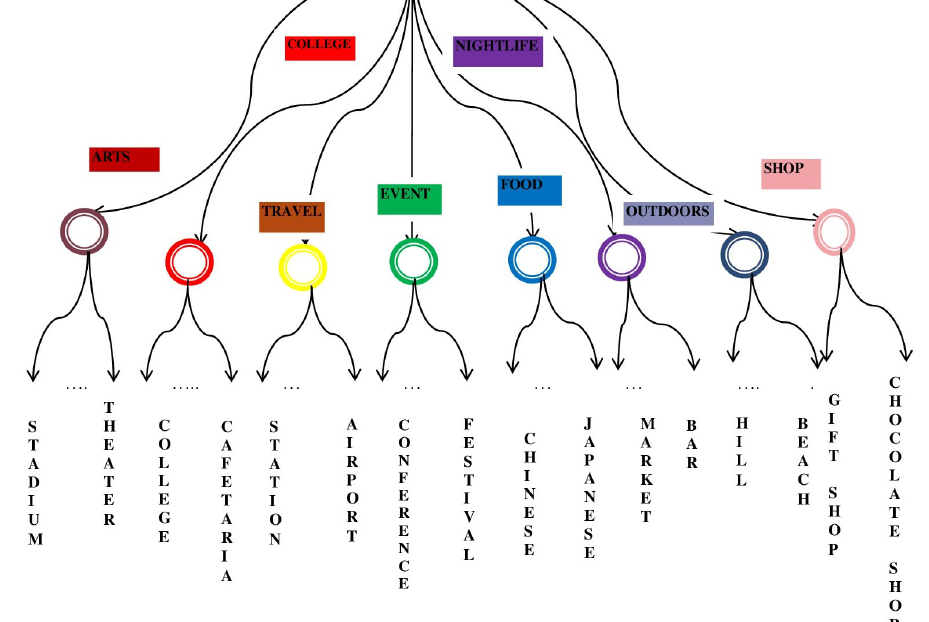
Figure 4. Category Tree.